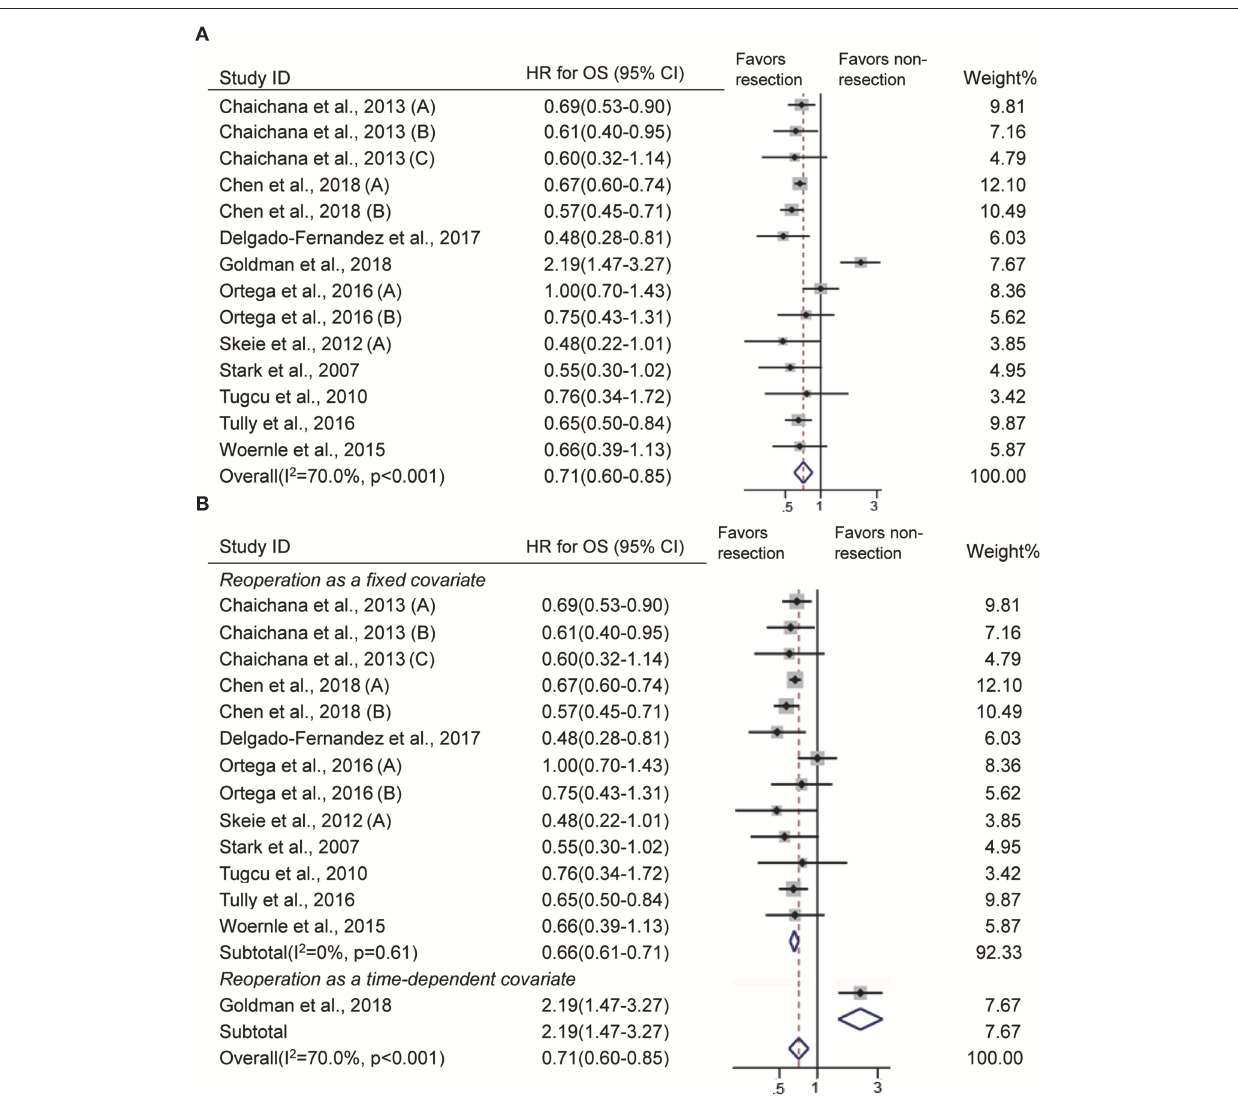
with OS, reoperation at recurrence was associated with